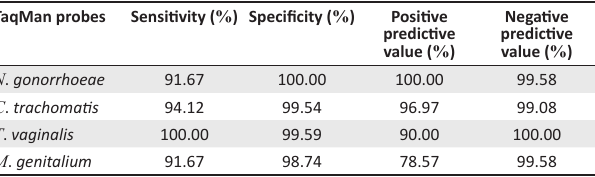
TABLE 2: Performance characteristics of TaqMan® probes for 250 vaginal swab specimens collected from patients attending Prince Cyril Zulu Communicable Disease Centre (Durban, South Africa) between May 2016 and January 2017. TaqMan probes Sensitivity ( % ) Specificity ( %